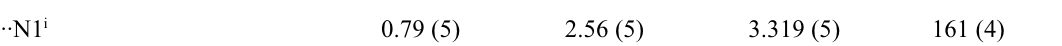
data-5 IUCrData (2019). 4 ,